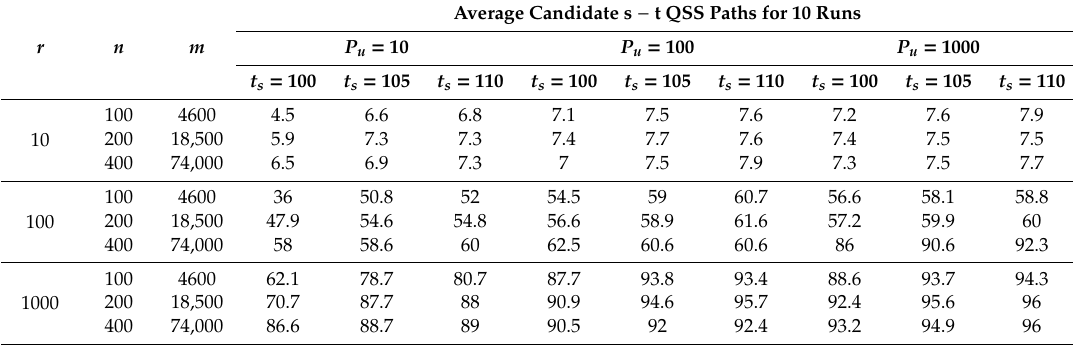
Table 5. The average candidate s − t QSS paths for the SESE algorithm for 10 Mb.